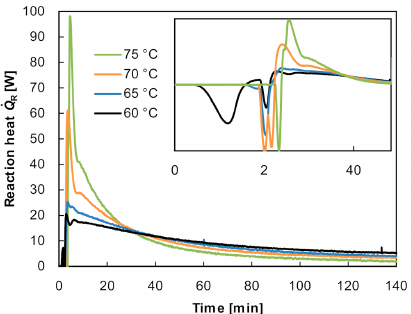
Figure 10. Heat of reaction curves of acrylic acid polymerisations in isopropyl alcohol (150 g/L, 0.5 mol% AIBN). Here, the reaction times are aligned to the beginning of the reaction according to the calorimetric global conversion. The inner graph is a copy using a logarithmically scaled time axis and displays the negative range of the reaction